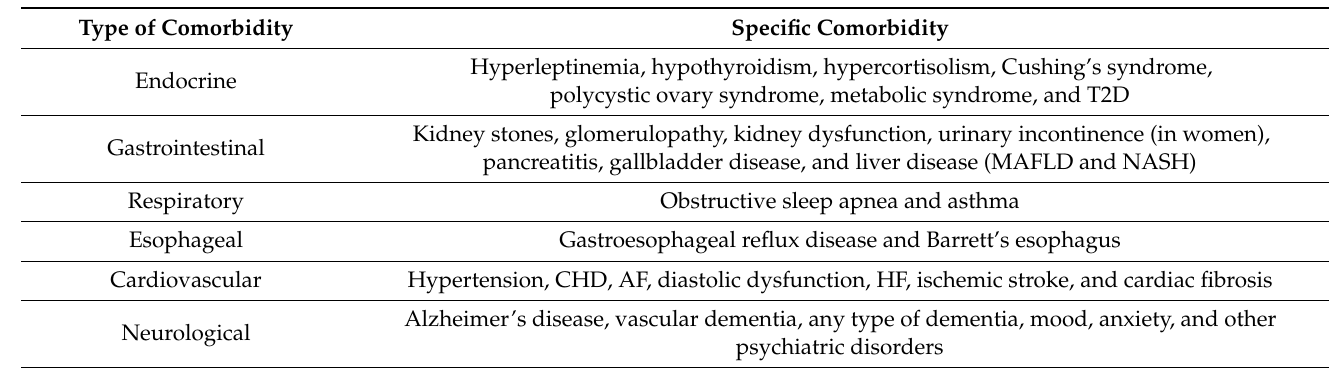
Table 2. Comorbidities related to